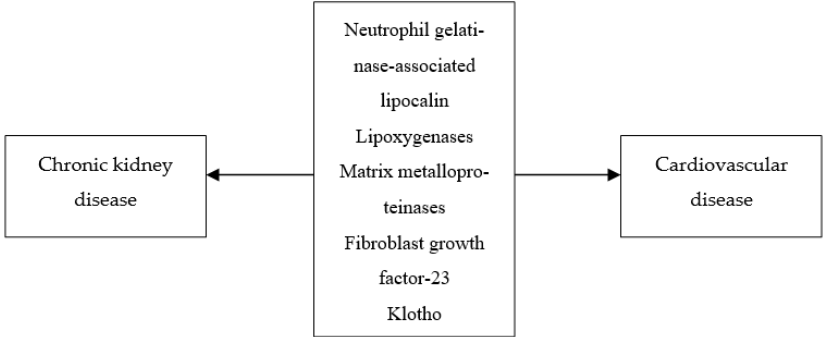
Figure 1. Factors associated with both chronic kidney disease and cardiovascular diseases in diabetic patients.